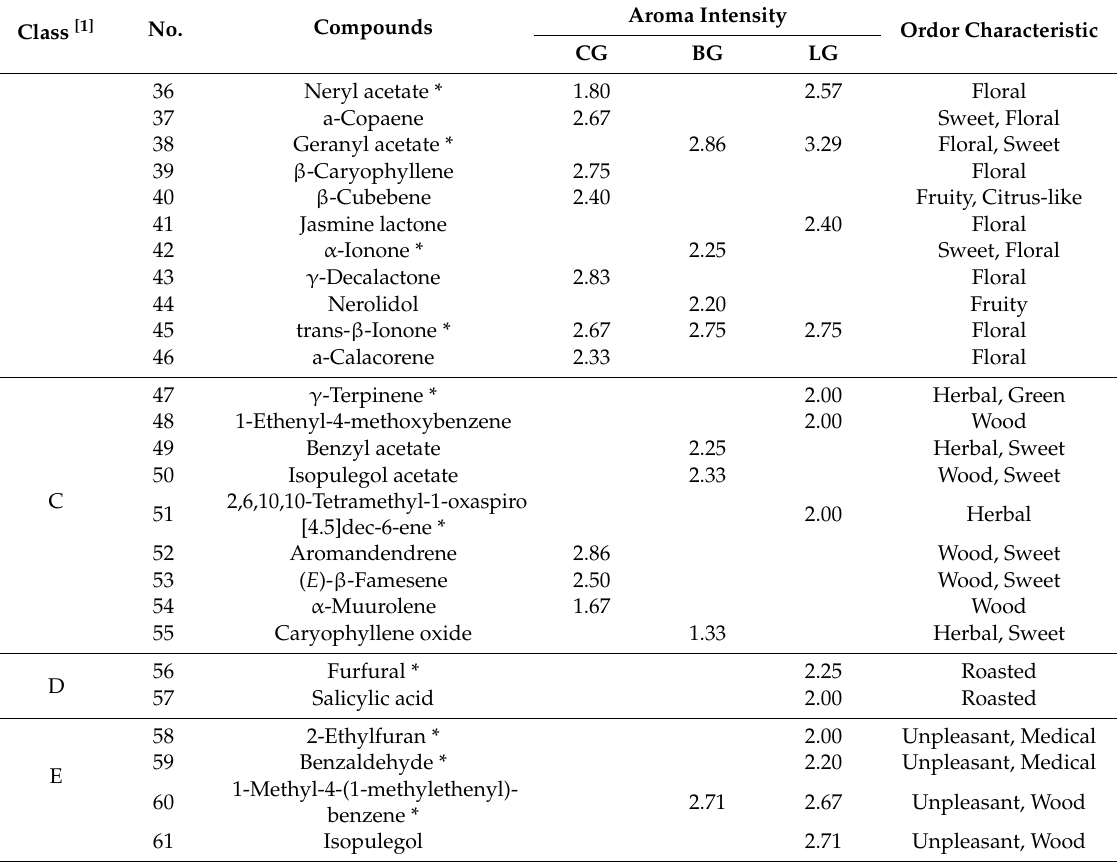
Table 3. Active aromatic compounds identified in citrus blend black